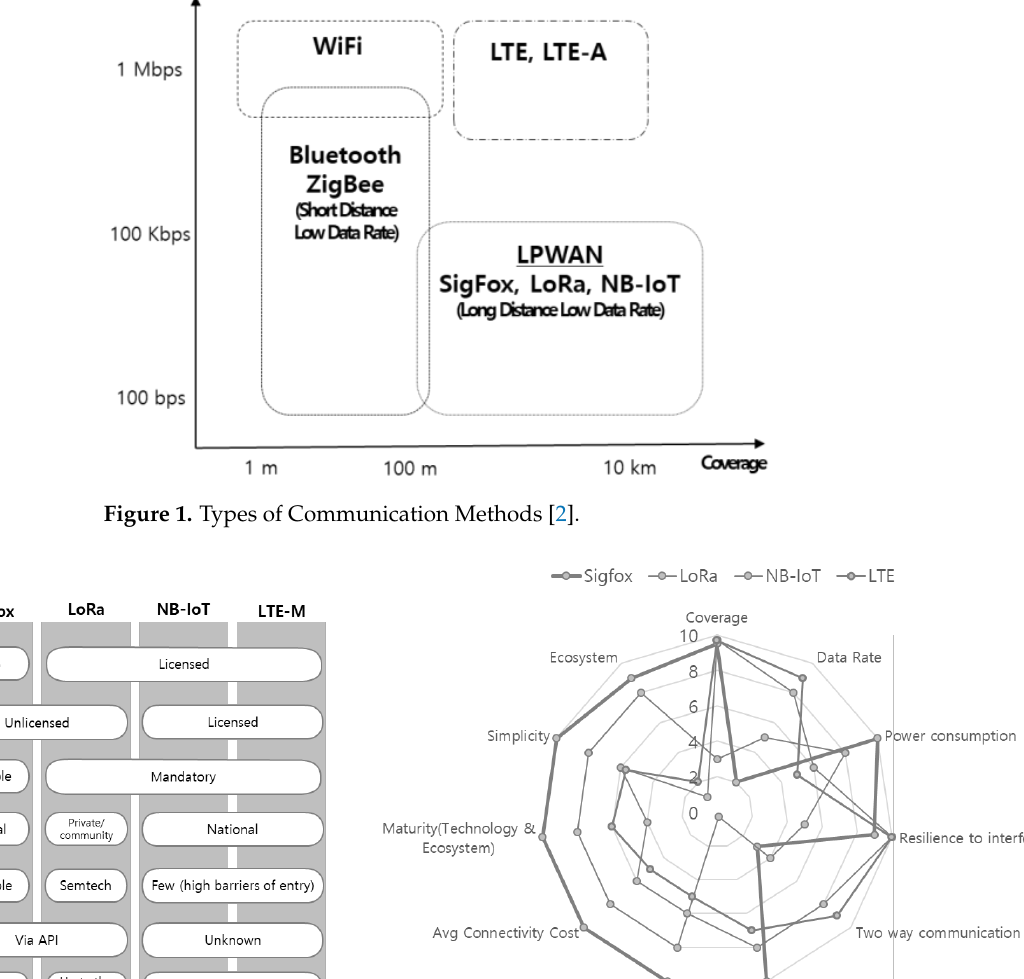
Figure 2. Features of Current Communication Technologies [3]. Table 1. Advantages and Disadvantages of Communication Methods [4 – 7].